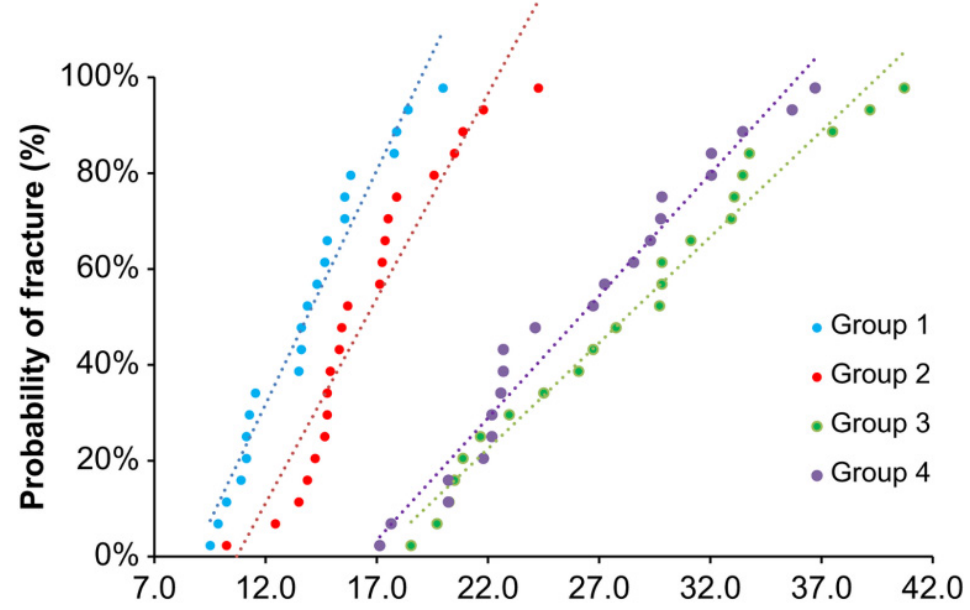
Figure 2. Weibull representation of the fracture data of the Group 1–4 samples.